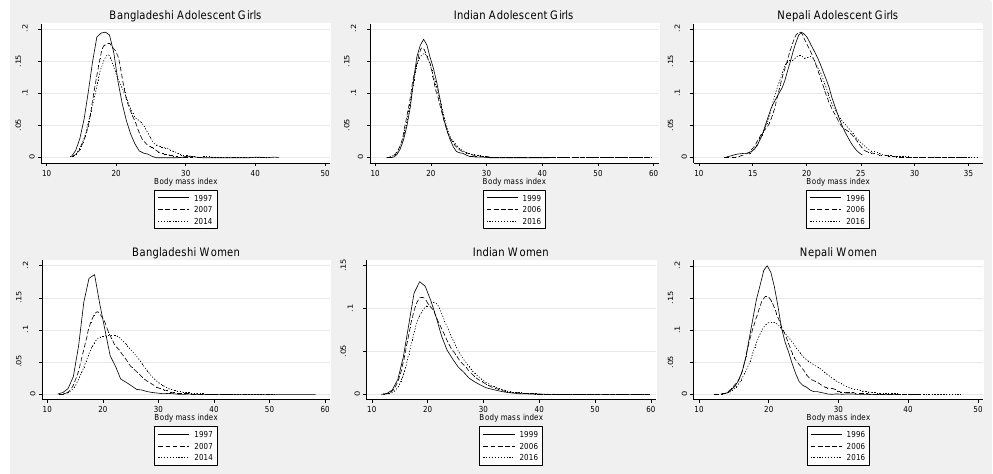
Figure 2. Distribution of body mass index (BMI) of adolescent girls and adult women in Bangladesh, India and Nepal over time.